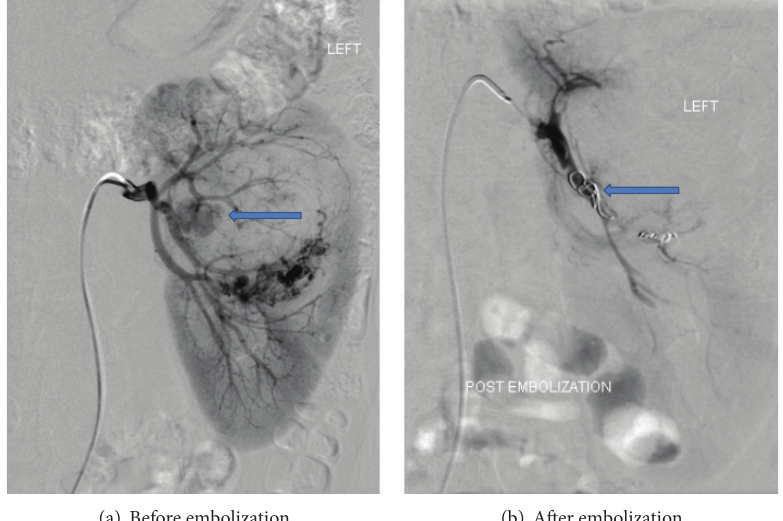
Figure 1: Digital subtraction angiogram. (a) Arrow pointing to a large pseudoaneurysm arising from segmental branch of left renal artery supplying the interpolar region. (b) Arrow pointing to a platinum coil deployed in the segmental branch of left renal artery with successful exclusion of pseudoaneurysm.